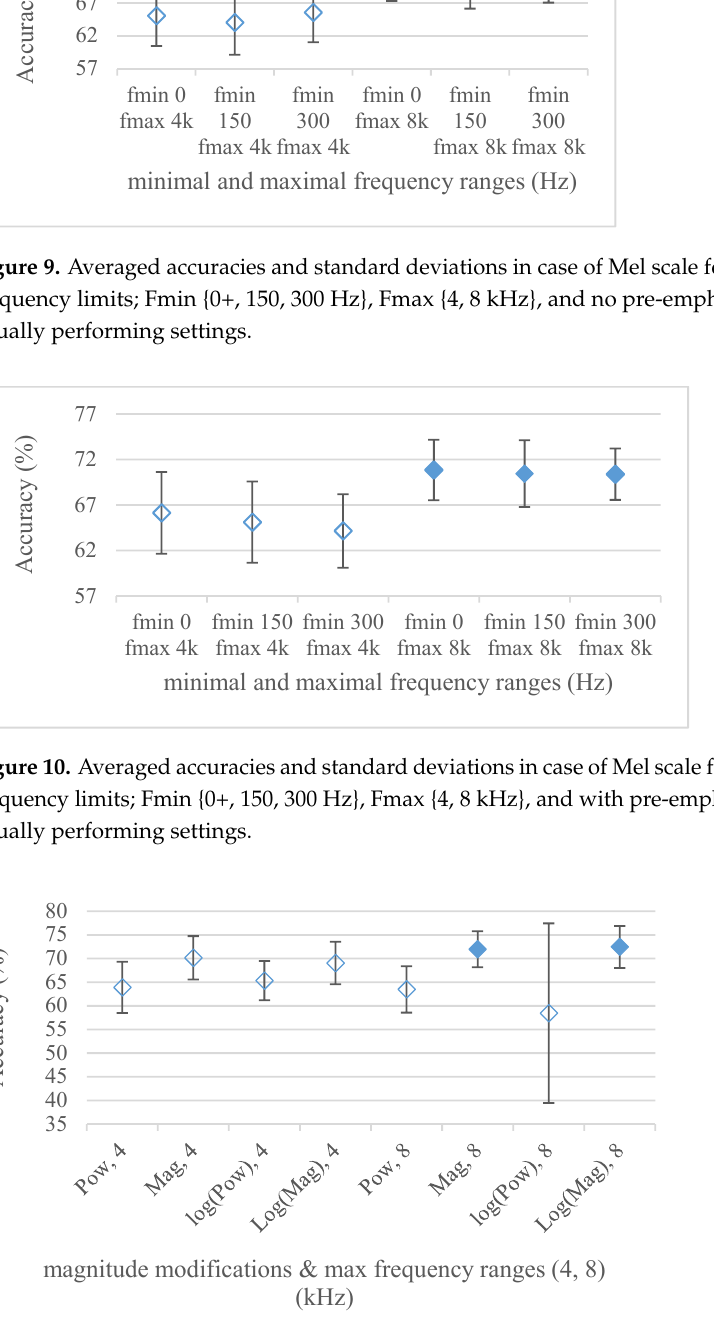
Figure 9. Averaged accuracies and standard deviations in case of Mel scale for minimal and maxi- mal frequency limits; Fmin {0+, 150, 300 Hz}, Fmax {4, 8 kHz}, and no pre-emphasis. Filled marks show equally performing settings.